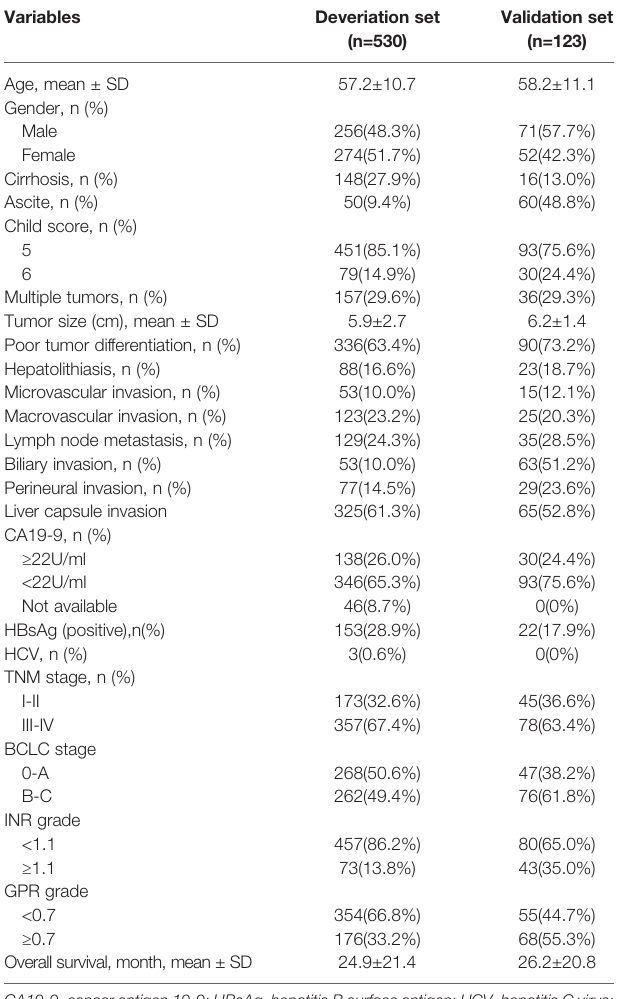
TABLE 1 | Baseline characteristics of